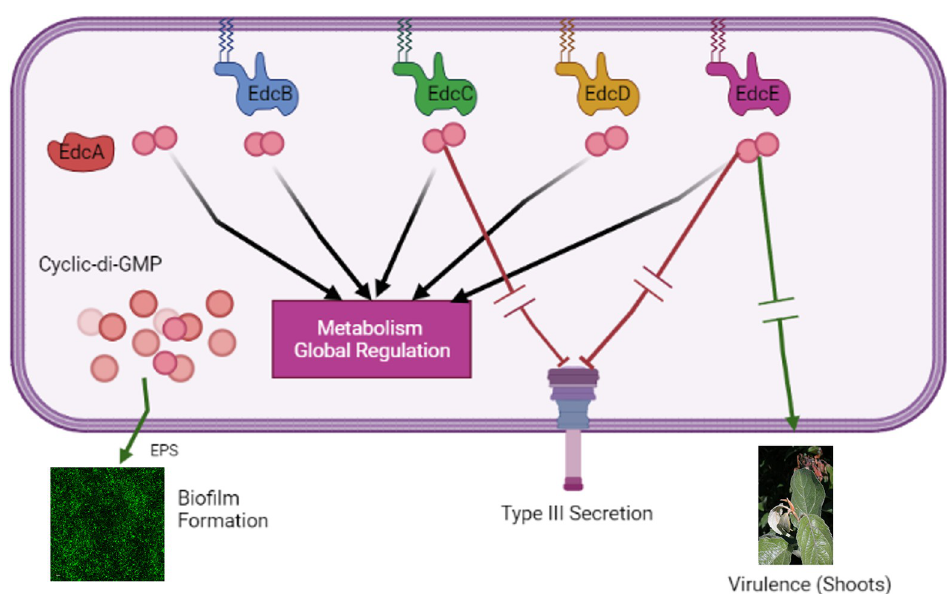
Fig 6. C-di-GMP regulatory model in surface exposed E . amylovora cells. Our study indicates that there is a dimorphism in the regulatory targets of the c-di-GMP generated by each of the five Edcs. While each Edc uniquely regulates the transcription of several genes, and virulence factors in vitro and in planta, attachment/biofilm formation (dependent on EPS production) is regulated by all the Edcs, thus, leading us to hypothesize about the potential presence of a localized and a diffused pool of c-di-GMP that can achieve these varied regulatory targets. Red inhibitor lines and green arrows indicate negative and positive regulation respectively, with arrow breaks indicating intermediate regulatory